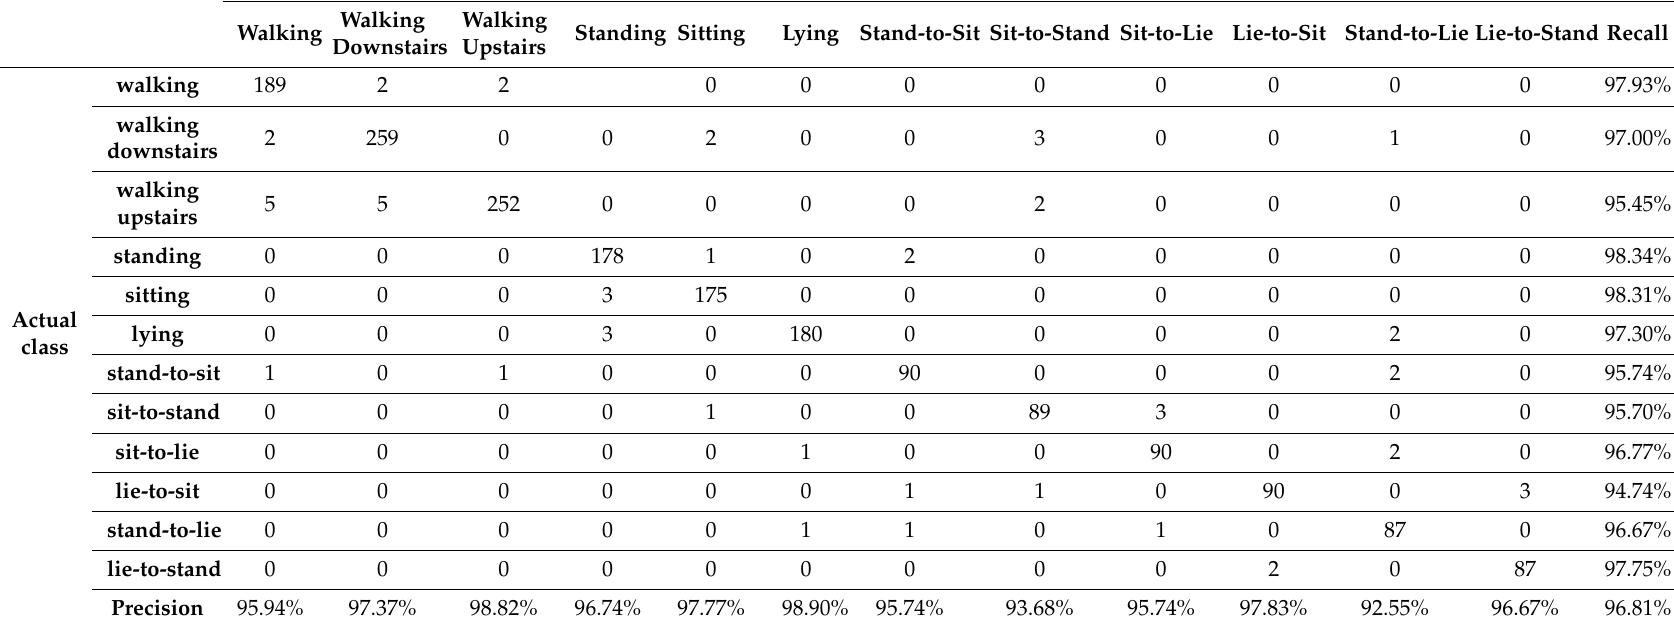
Table 4. Confusion matrix of classification using optimal feature